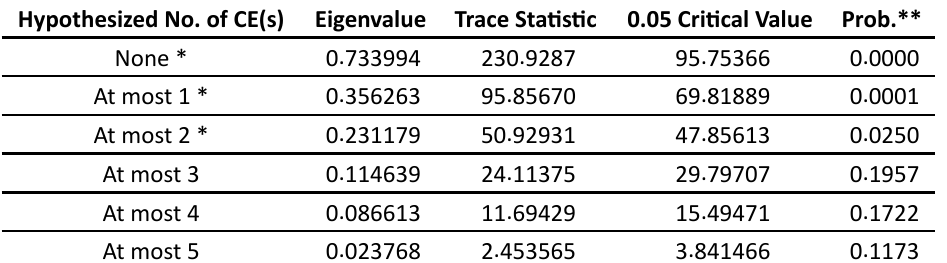
Table 4: Johansen Cointegration Test Results (Trace Statistic) Hypothesized No. of CE(s) Eigenvalue Trace